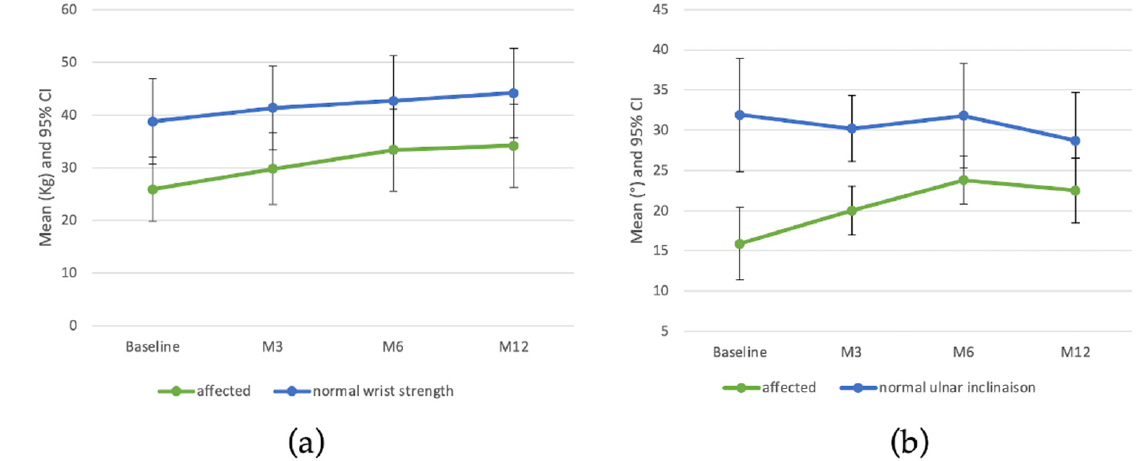
Figure 3. Wrist strength ( a ) and Ulnar inclination ( b ) over 12 months post treatment.